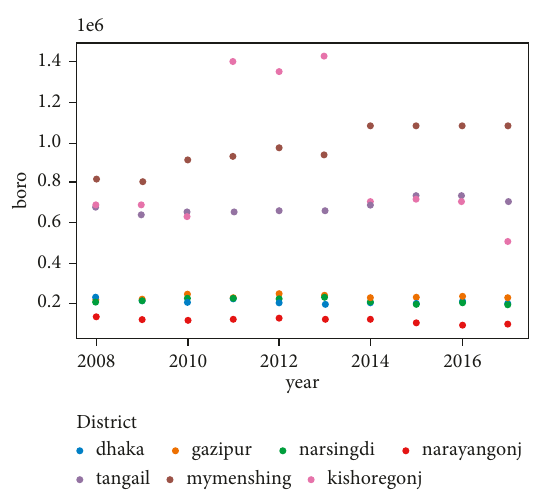
Figure 4: Year-wise (2008–2017) production of